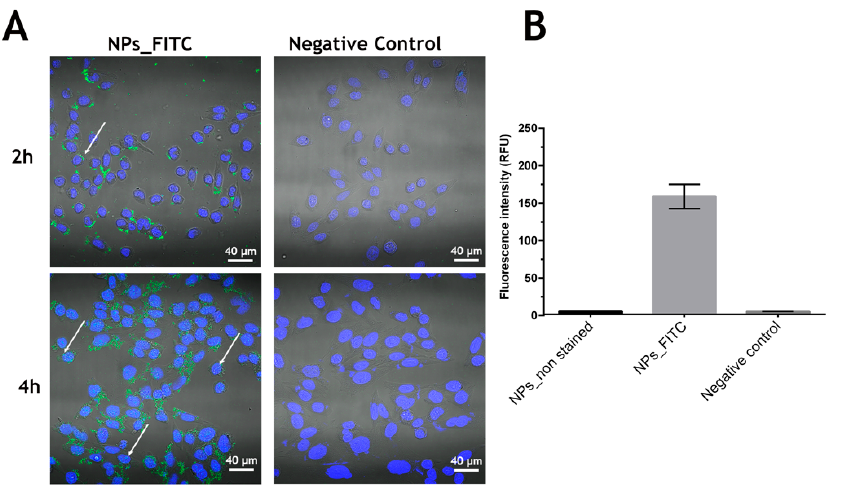
Figure 7. Analysis of NPs uptake in NHDF cells after 2 h and 4 h of incubation and a negative control ( A ) the white arrows point towards the internalized nanoparticles. Blue channel: the Hoechst 33342s stained cell nucleus; green channel: nanoparticles stained with FITC. ( B ) Quantification of the fluorescence intensity of FITC-stained nanoparticles after 4 h of incubation. Scale bar corresponds to 40 µm. Data are presented as mean ± SEM ( n = 3).